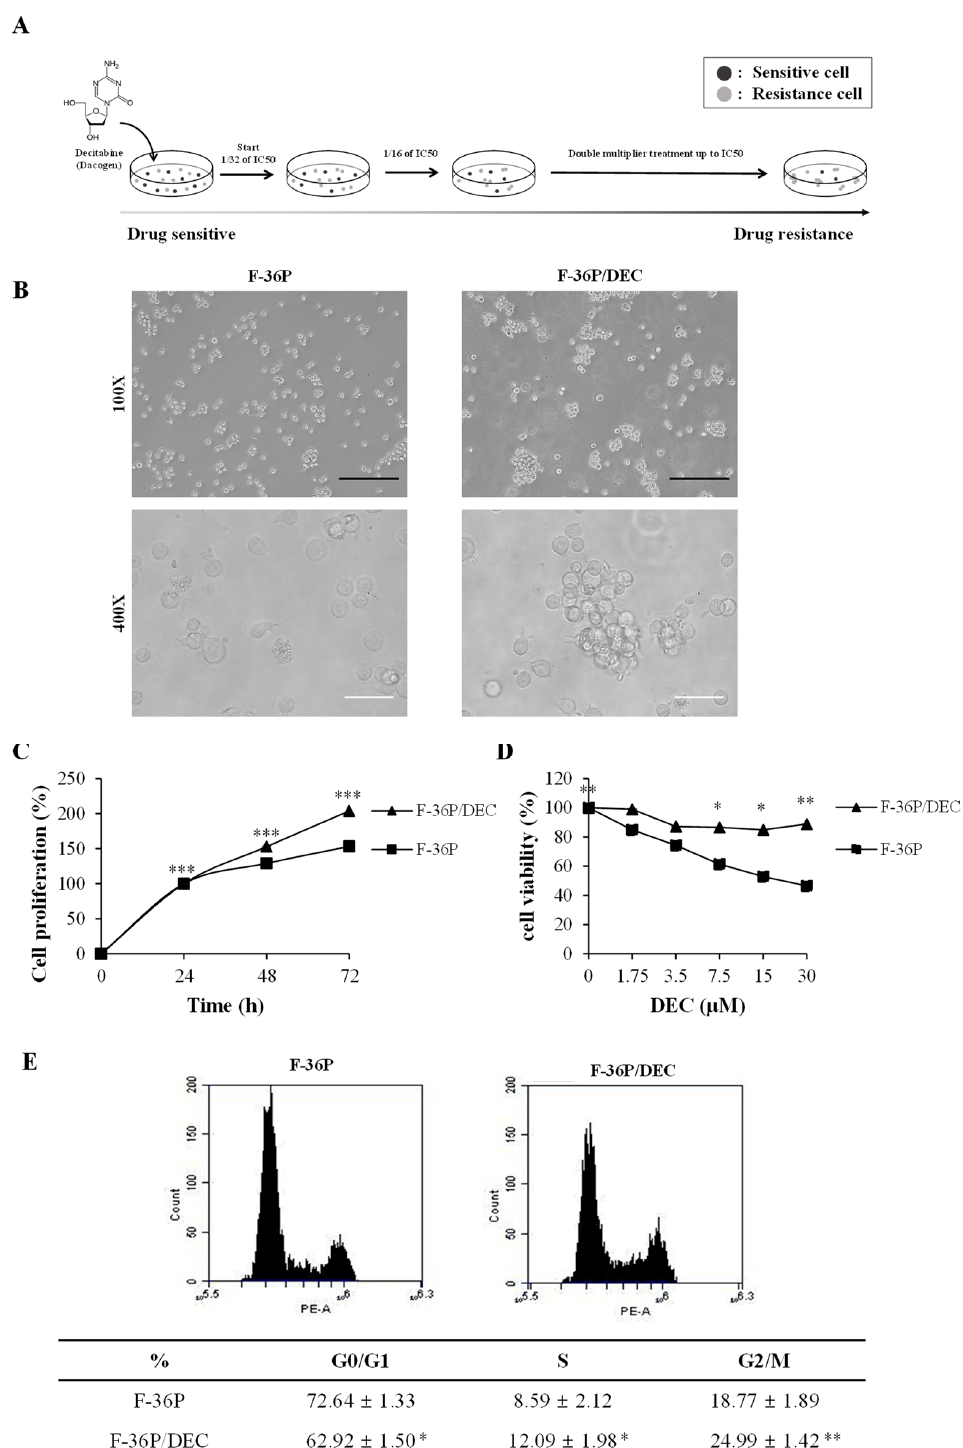
Figure 1. Validation of DEC resistance in the F-36P/DEC cell line. ( A ) Schematic showing how parental F-36P cells were used to create cells DEC-resistant F-36P/DEC cells. ( B ) Morphological observations of F-36P and F-36P/DEC cells. Magnification, 100 × and 400 × . Black scale bar, 250 µ m; white scale bar, 50 µ m. ( C ) The proliferation of F-36P and F-36P/DEC cells was analyzed by cell counting using WST assay kits and compared. ( D ) The viability of DEC-treated F-36P and F-36P/DEC cells was measured at 72 h using a WST assay and compared. ( E ) The cell-cycle distribution of F-36P and F-36P/DEC cells was measured by flow cytometry using propidium iodide (PI) and the G2/M phase ratio was determined and compared. Results are presented as means ± SD (error bars) ( n = 3; * p < 0.05, ** p < 0.01, *** p < 0.001 compared to the control).